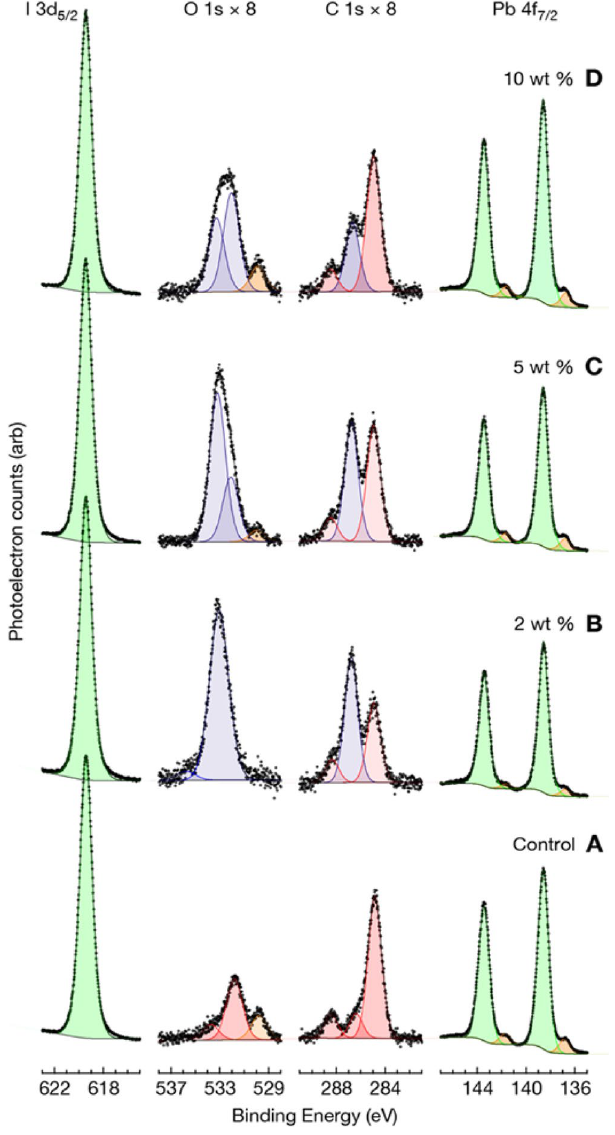
Figure 4. High-resolution XP spectra of perovskite films at different wt% of PEO ( A ) 0, ( B ) 2, ( C ) 5 and ( D )